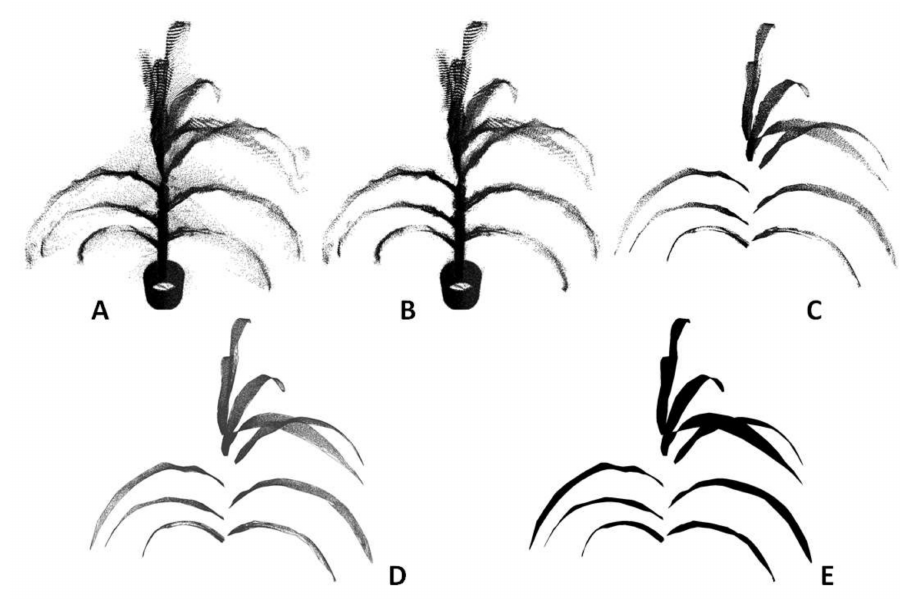
Figure 3. Example of 3D model of maize plant leaves after each step of point cloud processing: ( A ) raw point cloud of a maize plant derived by the instrument; ( B ) after voxelization and noise removal; ( C ) after clustering and segmentation; ( D ) after surface fitting and triangulation; and ( E ) a 3D rendering of the digital leaf surface model of the